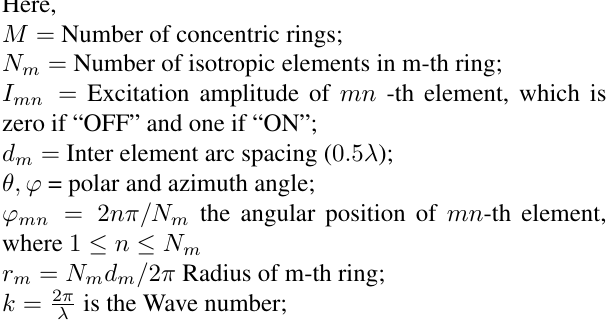
Here, M = Number of concentric